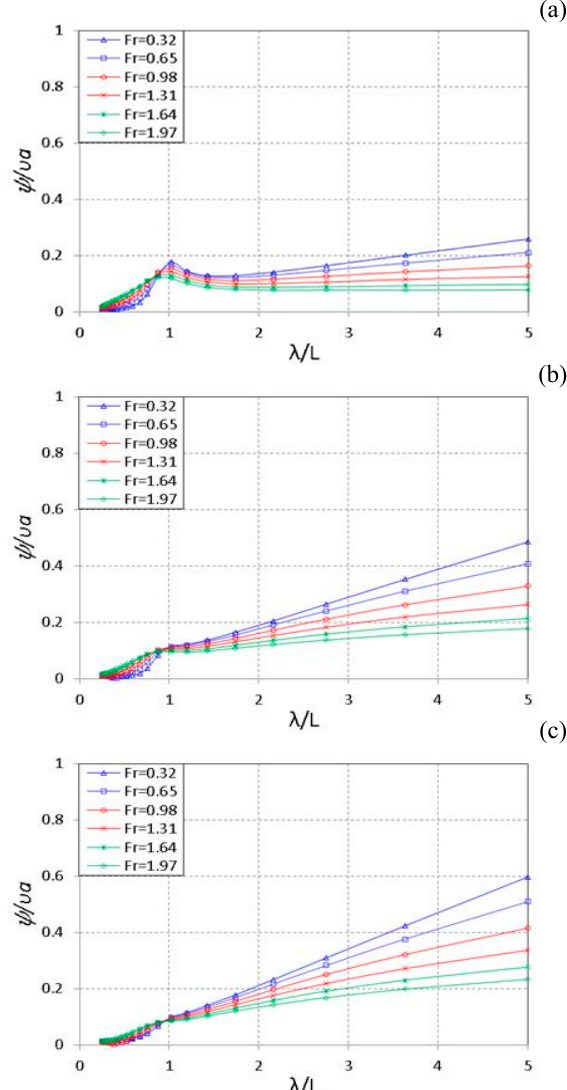
Figure 10. RAO comparison of yawing motion for various Froude numbers at μ = 90° with respect to ( a ) τ = 0°, ( b ) τ = 1°, and ( c ) τ = 2°.